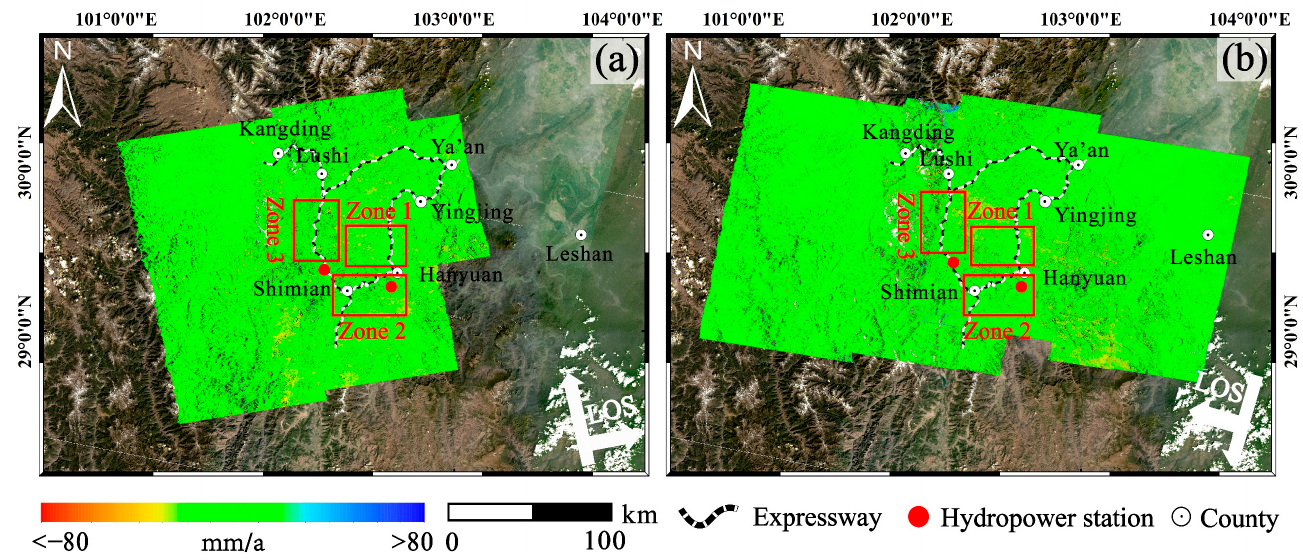
Figure 5. LOS annual surface deformation rate map along the Yakang, Yaxi, and Lushi expressways: ( a ) ascending track, and ( b ) descending track. Negative value (red color) and positive value (blue color) indicate that the Earth’s surface is moving away from and towards radar sensor, respectively.